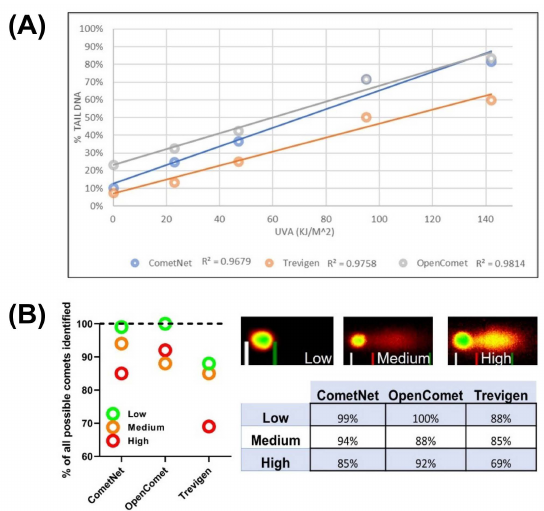
Figure 1. Comparison of the ability of three comet analysis (CAS) software packages to measure DNA damage over a linear range of DNA damage as measured by comet analysis. ( A ) Damage was induced using UVA (365 nm) light. Each data point represents averages of 100–300 comet cells from replicate biological experiments; r 2 = linear regression of data set. ( B ) Both CometNet and OpenComet were able to identify significantly more comets than the Trevigen software. CometNet vs. Trevigen ( p > 0.0001), OpenComet vs. Trevigen ( p = 0.0001), n = 26 (technical sets). Comet images show representative comets of high, medium, and low levels of DNA